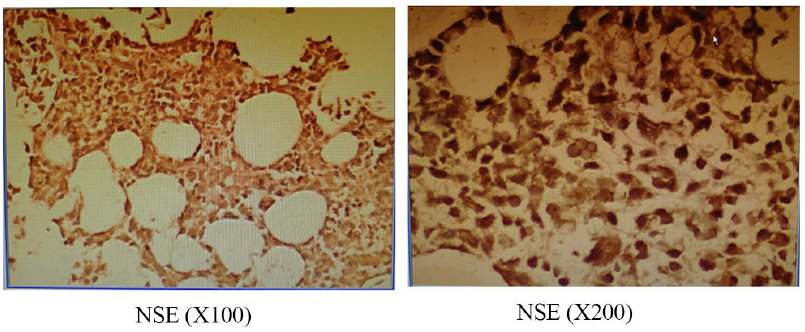
Figure 1. NSE immunohistochemical results of patients with previously untreated MM.